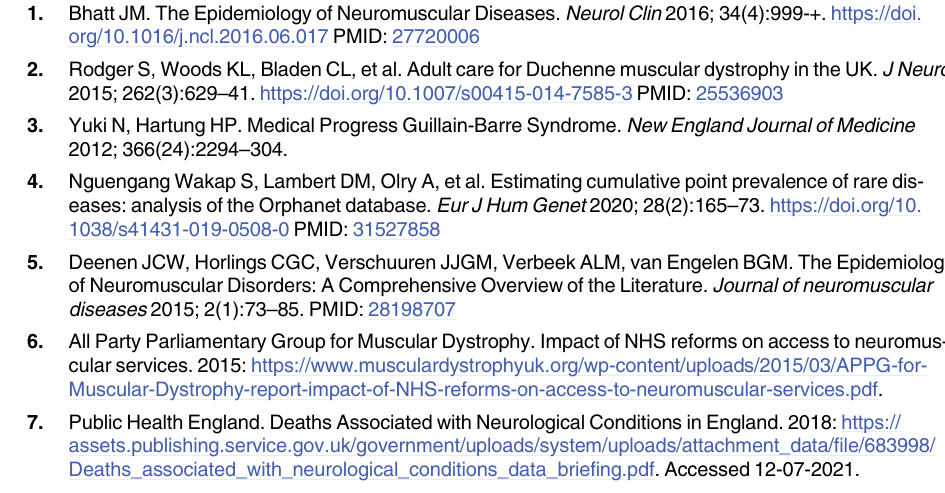
S23 Table. Population standardised prevalence (2019) and incidence (2015–9) of recorded neuromuscular disease in the UK with estimated number of people. S24 Table. Estimated numbers of people in UK with recorded neuromuscular disease com- pared with published estimates for Parkinson’s and multiple sclerosis using other CPRD